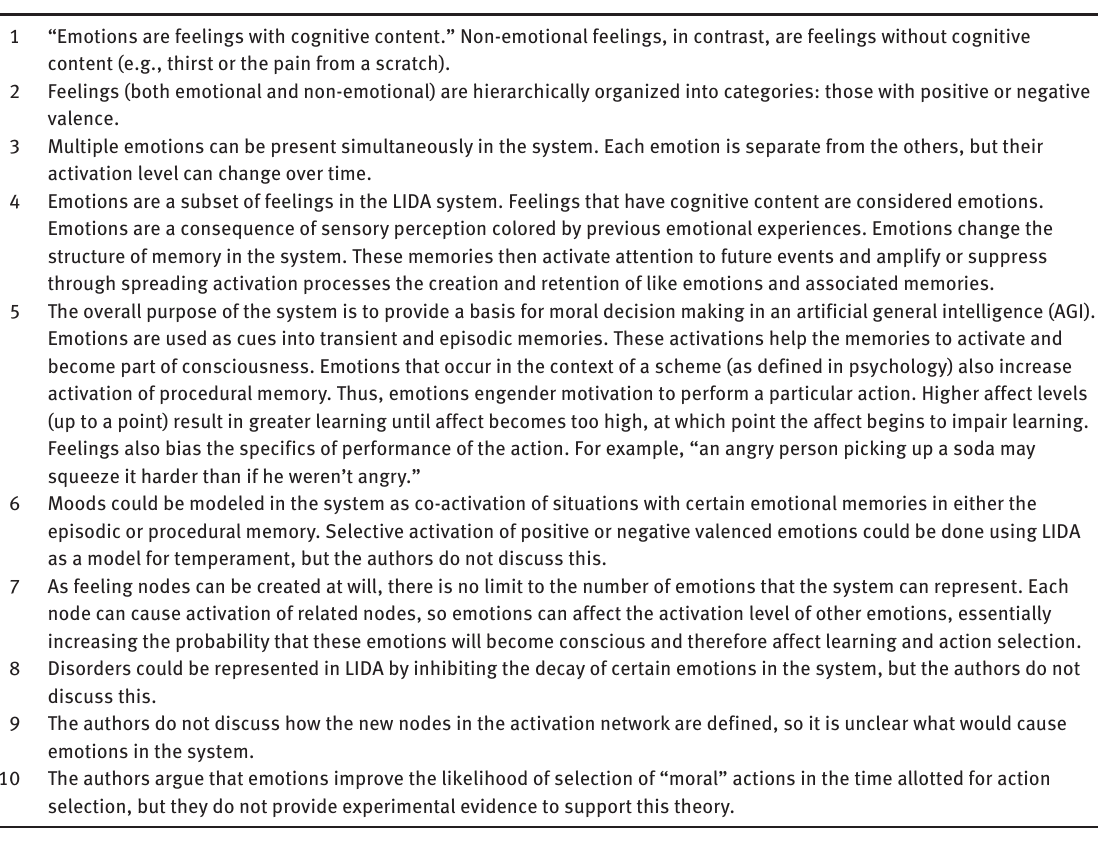
Table 13. Classification of LIDA